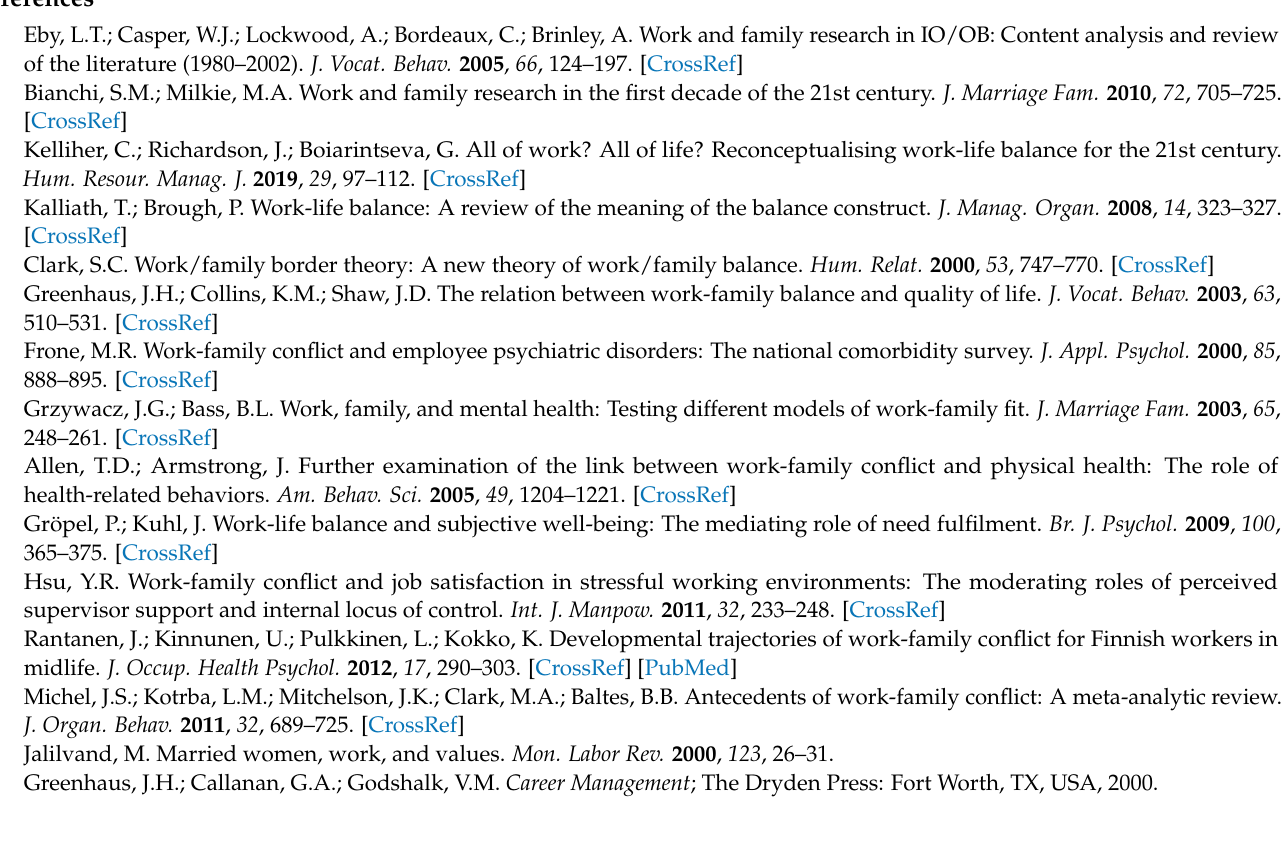
Table S3. Path analyses. Figure S1. Path of maternal work–life balance, perceived stress, parenting practices, and children’s